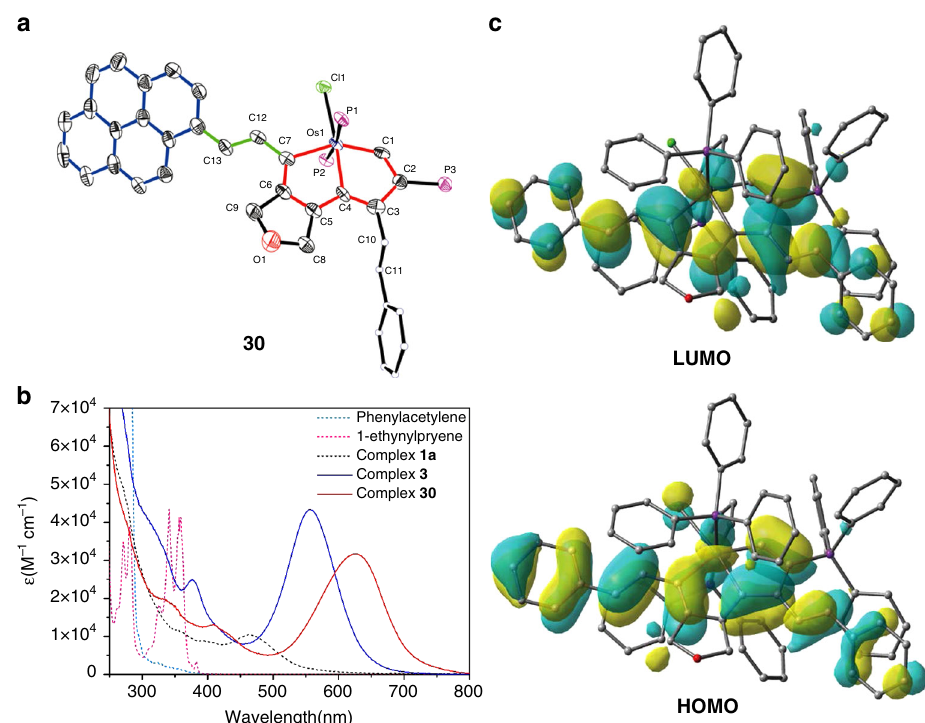
Fig. 5 Construction of large d π – p π conjugated systems. a X-ray molecular structure for the cation of complex 30 ′ . Ellipsoids are at the 50% probability level, phenyl groups in PPh 3 are omitted for clarity. b UV – Vis absorption spectra of phenylacetylene, 1-ethynylpyrene, complex 1a , complex 3 and complex 30 measured in DCM at RT (1.0 × 10 -5 M). c Selected orbitals related to the excitation of complex 3 (isovalue = 0.02).